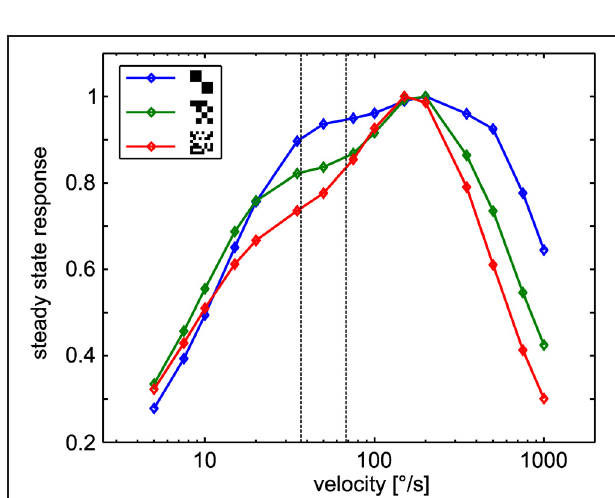
FIGURE 4 | Systematic variation of trajectory parameters. Responses for trajectories with different radius( r ) and translational velocity ( v ). Each panel shows the response contrast (difference of the HSEsignals normalized bytheir sum) for textures composed of large, medium and small texels. The radius of